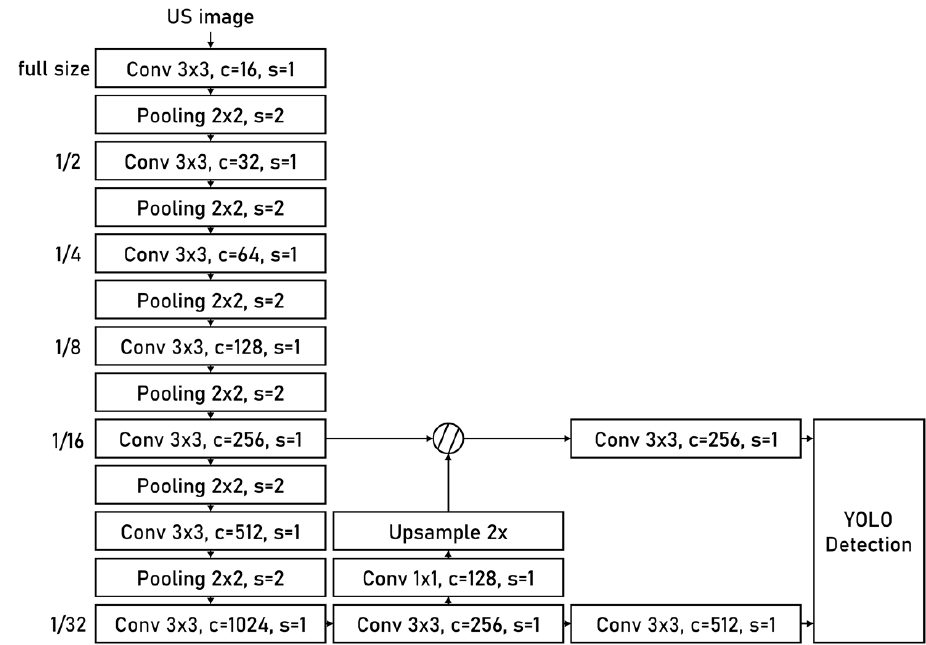
Figure 3. Overview of the YOLOv3-tiny network.